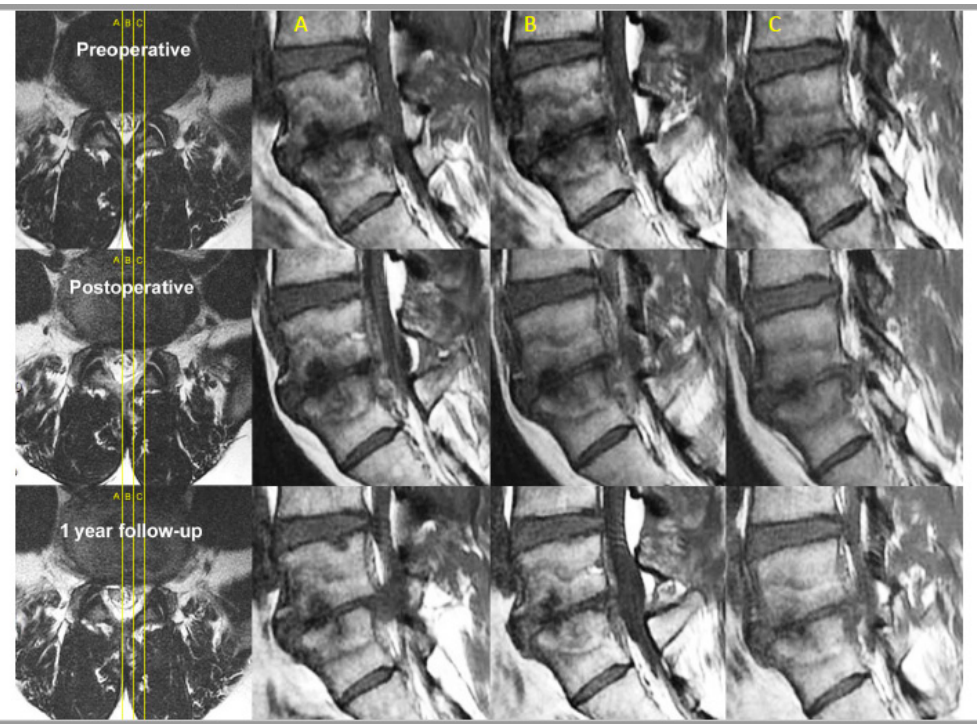
Figure 9. Sagittal cuts across L5/S1 in a patient with spinal canal stenosis, degenerative disc